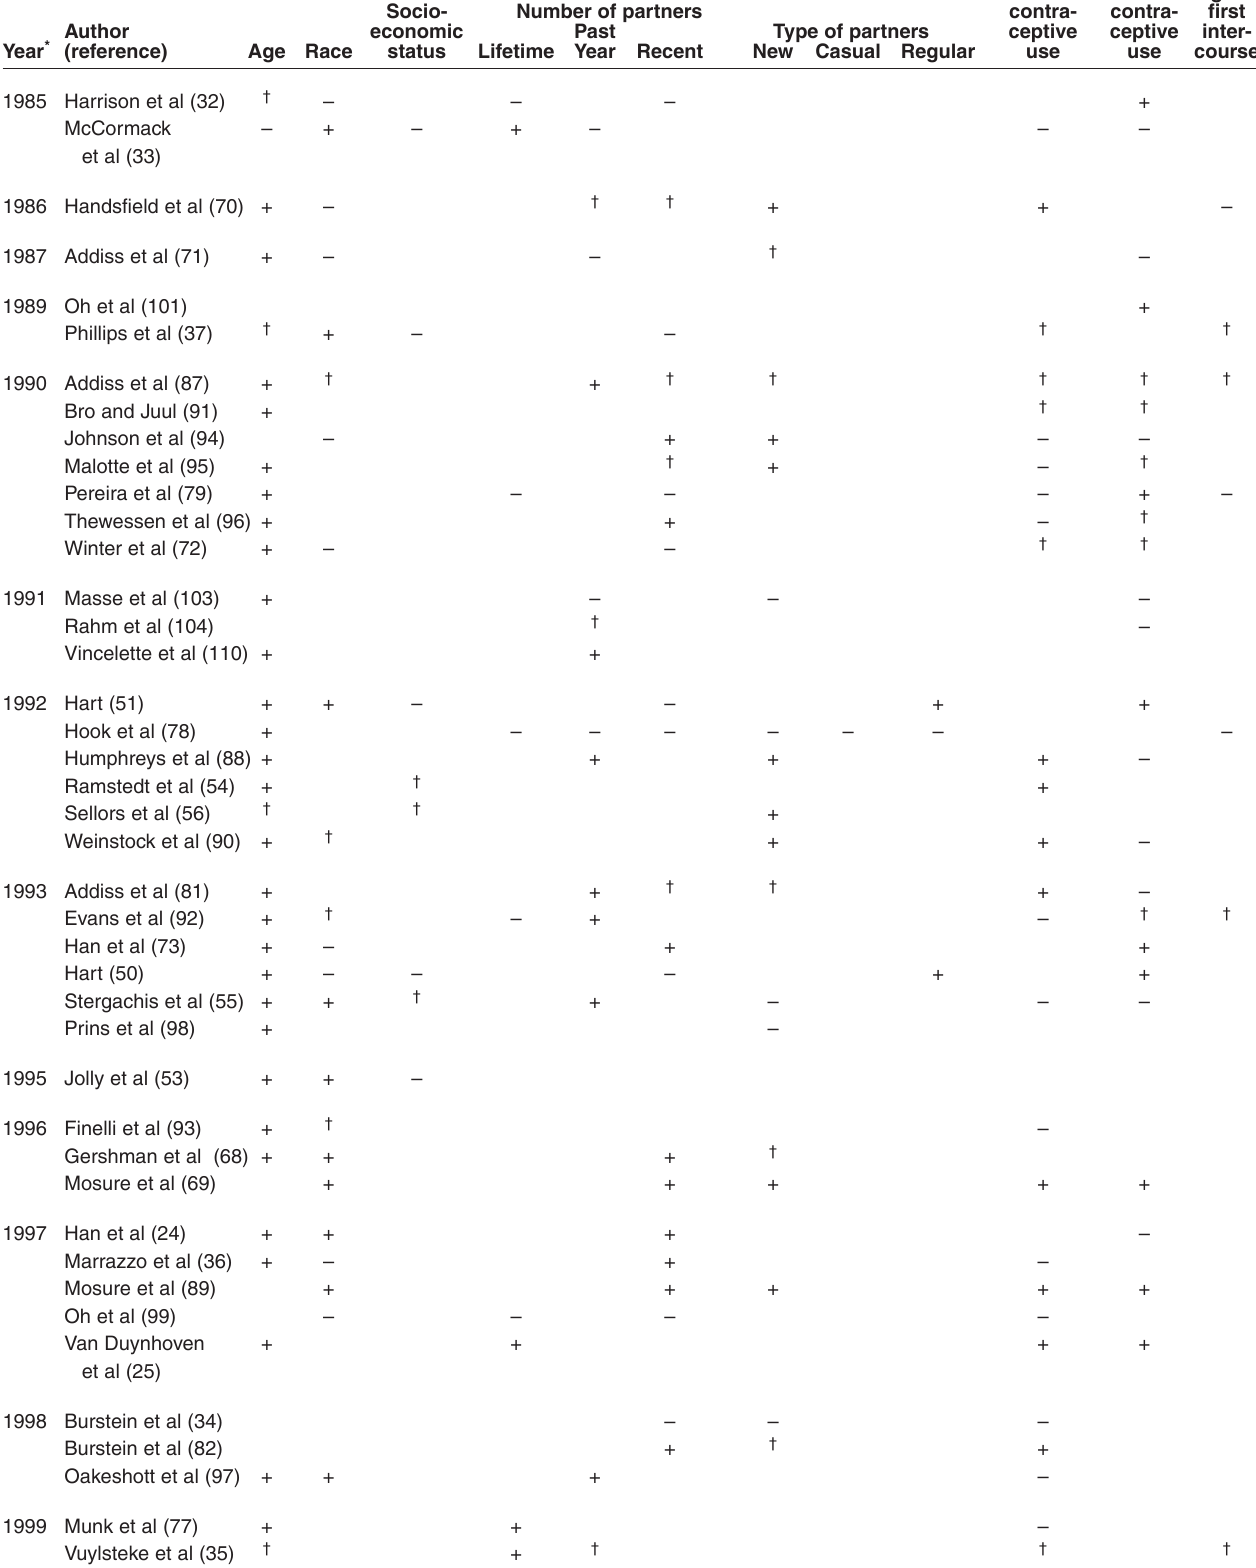
TABLE 3 Risk factors for chlamydia in